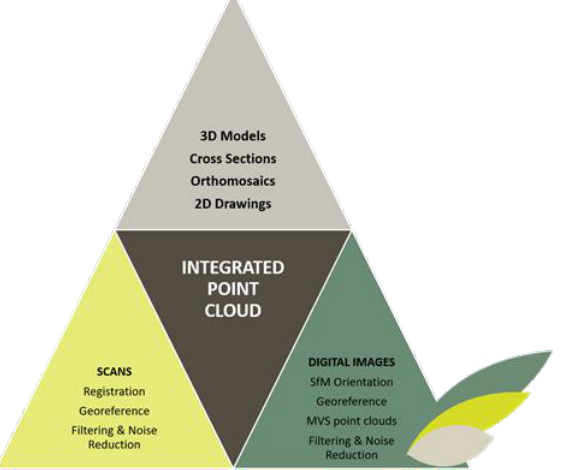
Figure 5 . The workflow of data processing.